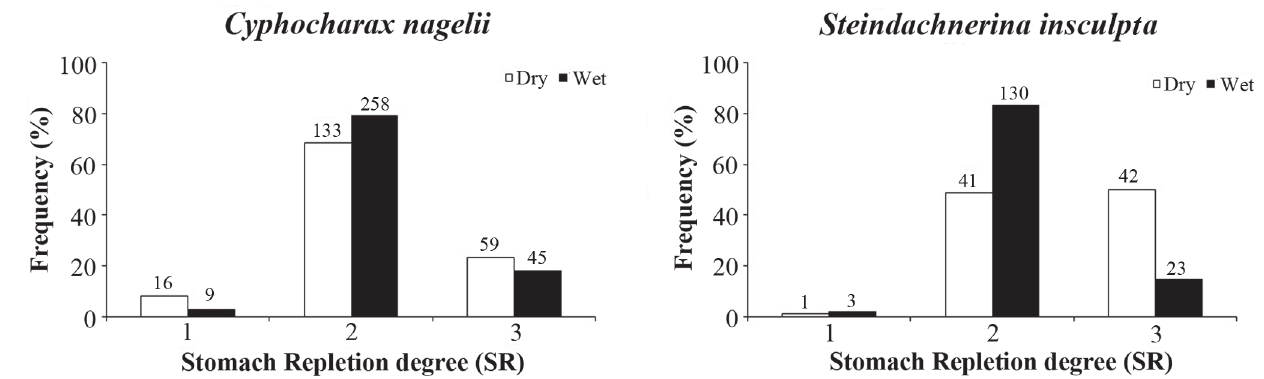
Fig. 1. Stomach repletion degree (SR) of Curimatidae species during dry and wet seasons. 1: empty stomachs, 2: partially filled stomachs, and 3: full stomachs. Values above bars represent the absolute number of stomach repletion degrees obtained in each